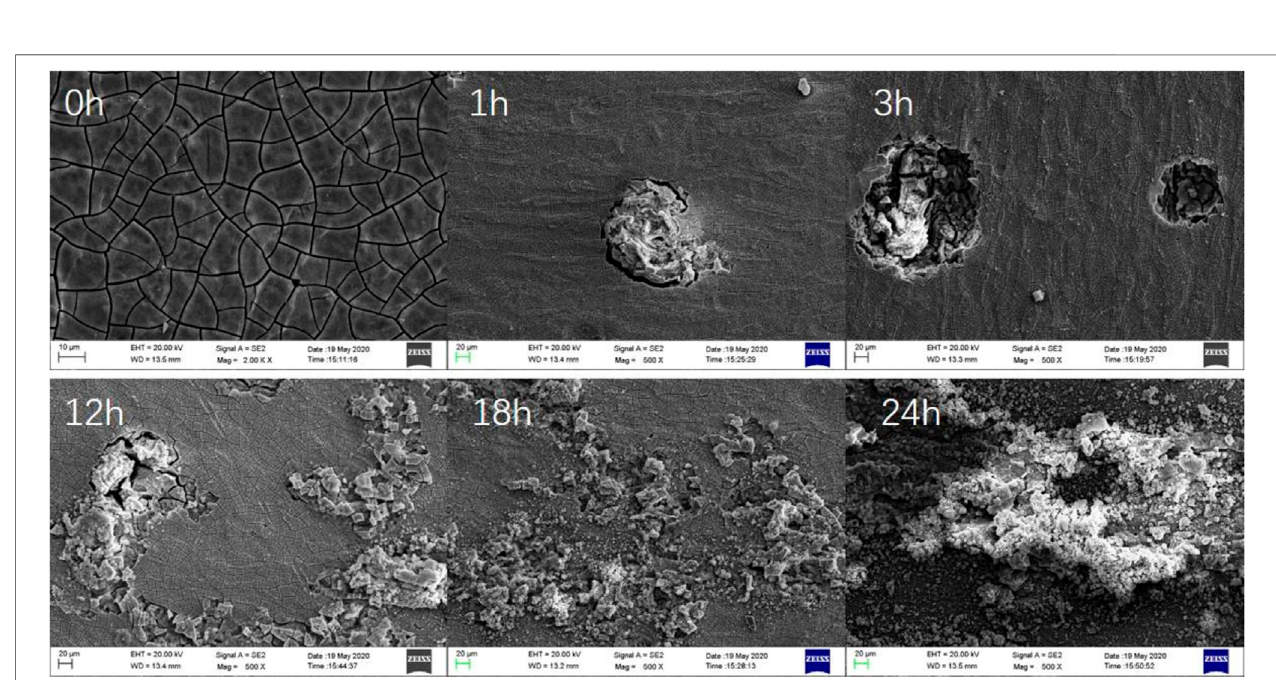
FIGURE 3 | SEM morphologies of the specimens in 3.5% NaCl solution.